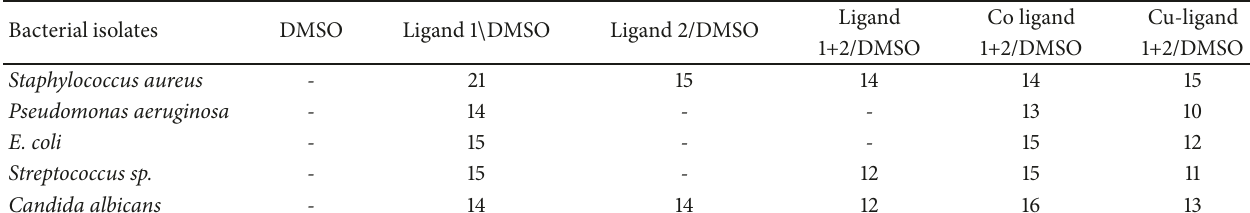
Table 4: Biological activities of the ligands and their complexes against different bacterial isolates. Bacterial isolates DMSO Staphylococcus aureus Pseudomonas aeruginosa Streptococcus